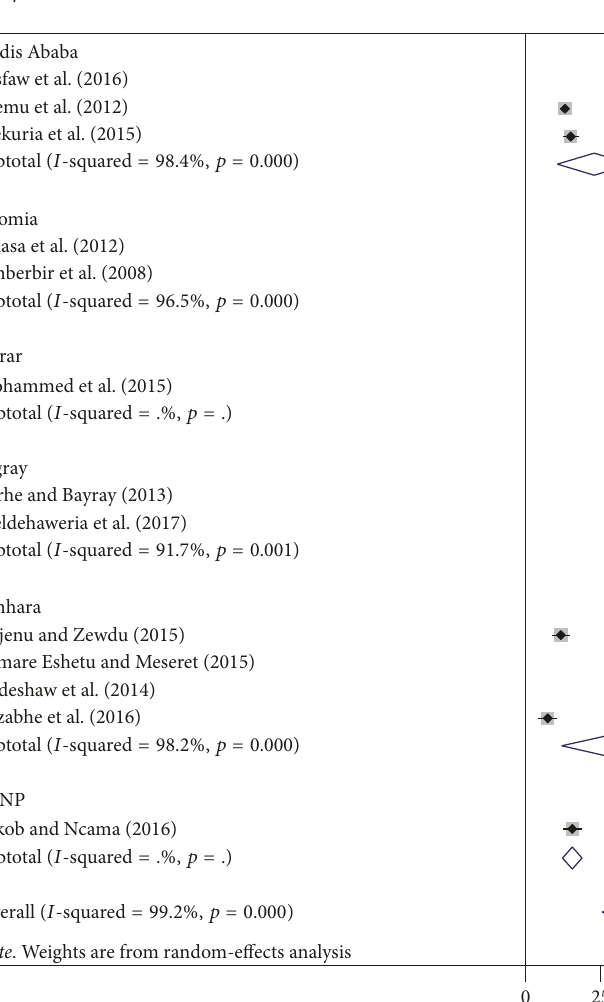
(Addis Abba = 3 studies; Amhara = 4 studies). The finding of Addis Ababa was lower than that of Oromia